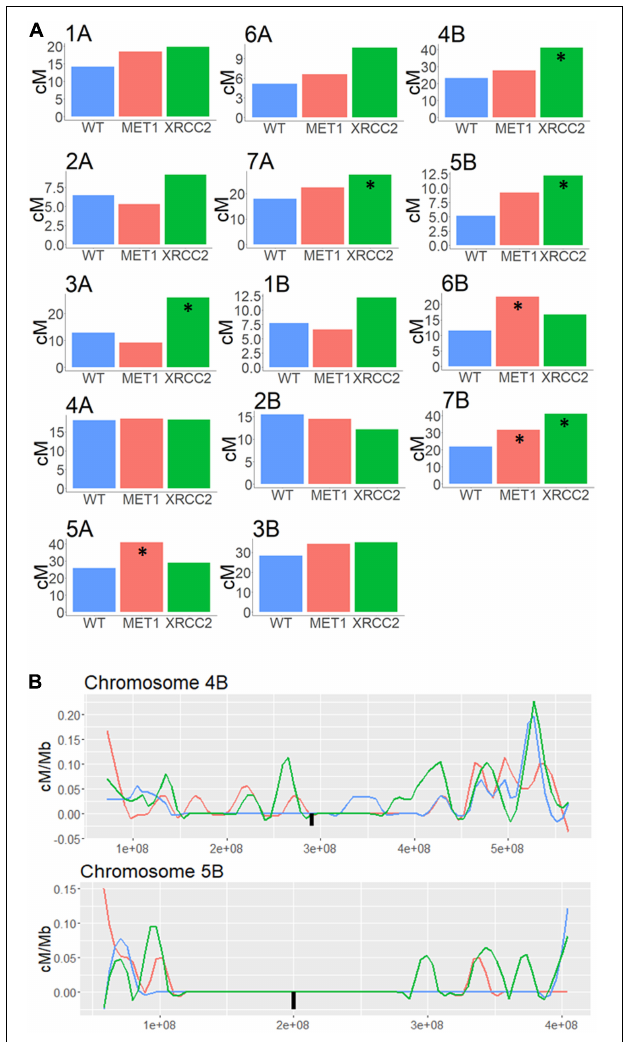
FIGURE 5 | Genetic distance analysis in Pericentric regions of F2 (Zavitan x Svevo) populations derived from F1 plants treated by either MET1-VIGS or XRCC2-VIGS during meiosis compared to untreated F1s (WT). (A) Genetic distance (centi-Morgans) of pericentric region in each chromosome. Asterisk marks treatments significantly different from untreated WT (chi-squared test, p < 0.05). (B) High resolution analysis of genetic distance (centi-Morgans/Mb) in pericentric regions of chromosome 4B and 5B in F2 (Zavitan x Svevo) populations derived from F1 plants treated by MET1-VIGS (Red, N = 87), XRCC2-VIGS (Green, N = 82) or untreated WT control (Blue, N = 89). The X -axis represent bp in Zavitan chromosomes. The Black square represents the centromere